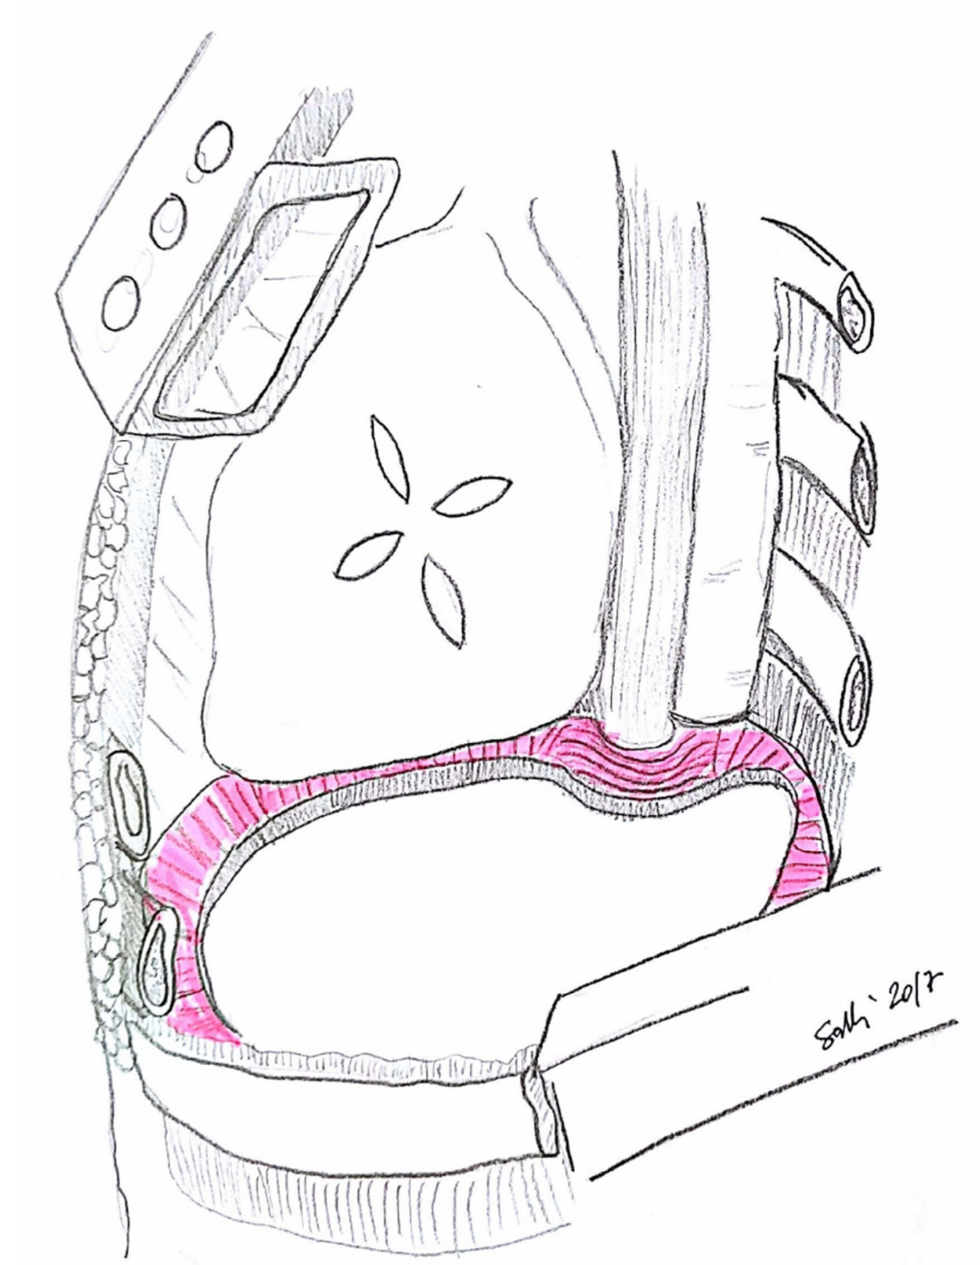
Figure 1. The diaphragmatic rim left in place for suturing diaphragmatic patch (credits: Solli, P.; Brandolini, J.; Pardolesi, A.; Nardini, M.; Lacava, N.; Parri, S.F.; Kawamukai, K.; Bonfanti, B.; Berto- laccini, L. Diaphragmatic and pericardial reconstruction after surgery for malignant pleural mesothelioma . J. Thorac. Dis. 2018, 10,